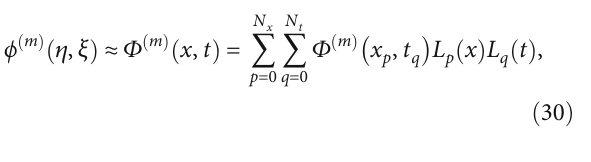
: 8, ξ = 1, N N f = Sr = Bi = 0 : 5, He = b = t = D w = 0